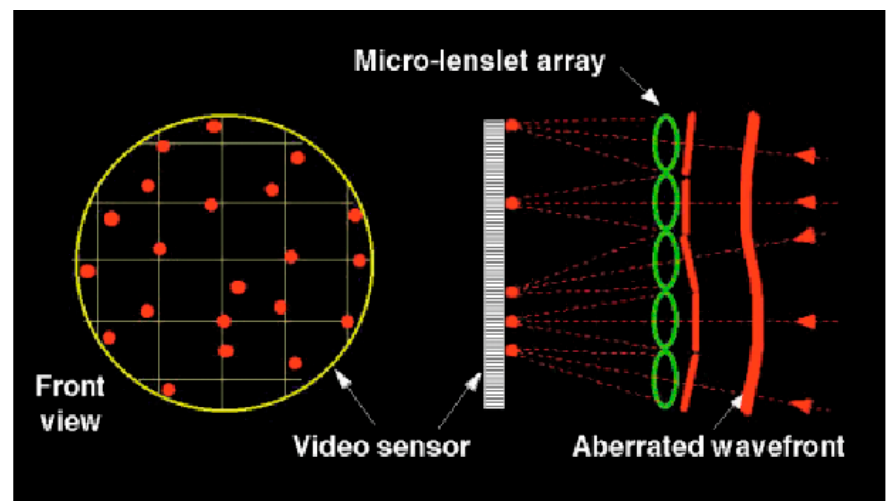
Figure 3. Working principle of the Shack–Hartmann sensor: the micro-lenslet array (green ellipses) creates spots (full red circles) on the sensor according to the wavefront (big solid red line) coming out of the eye. Figure reused with permission from Ref. [47] Larry N. Thibos, Principles of Hartmann-Shack Aberrometry, Journal of Refractive Surgery 16, S563-S565, 2000, copyright International Society of Refractive Surgery.